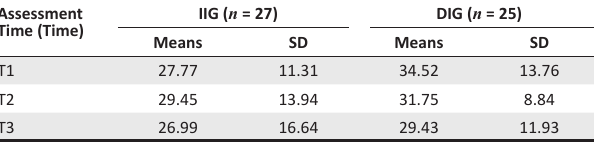
TABLE 1a: Means and standard deviations for the total score on the Revised Child Anxiety and Depression 30-Item Scale for the immediate intervention group ( n = 27) and delayed intervention group ( n = 25) from T1 to T4.